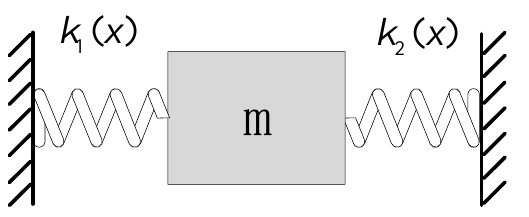
Figure 4. Hydraulic spring stiffness model.